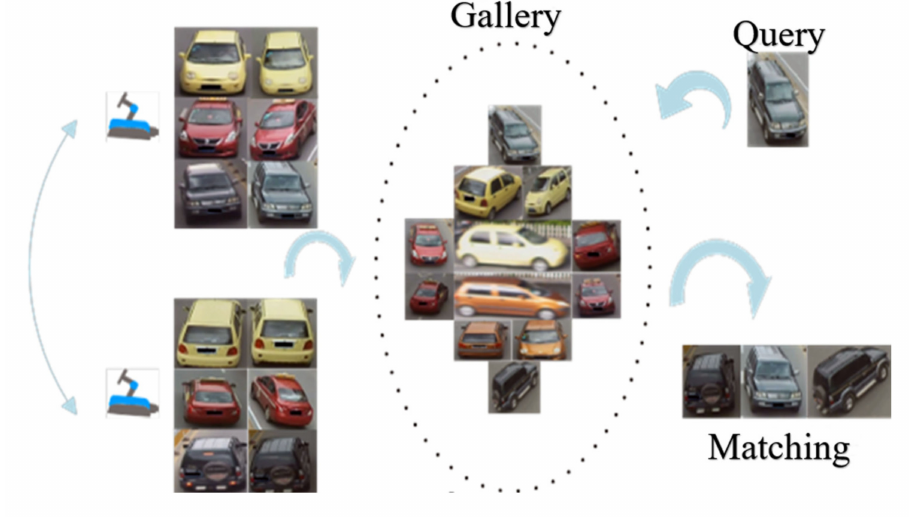
Figure 9. The vehicle re-id problem: given a Query, find the matching candidate in the